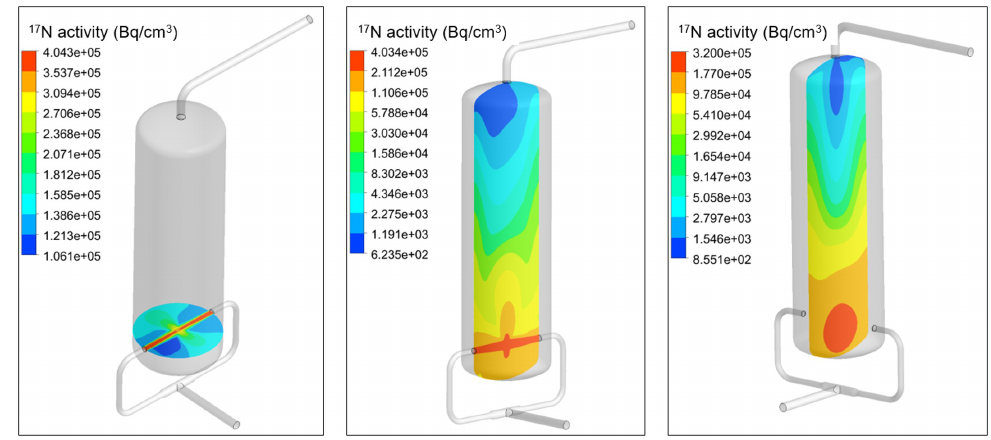
Figure 12. 17 N Activity [Bq cm − 3 ] in water inside the delay tank.